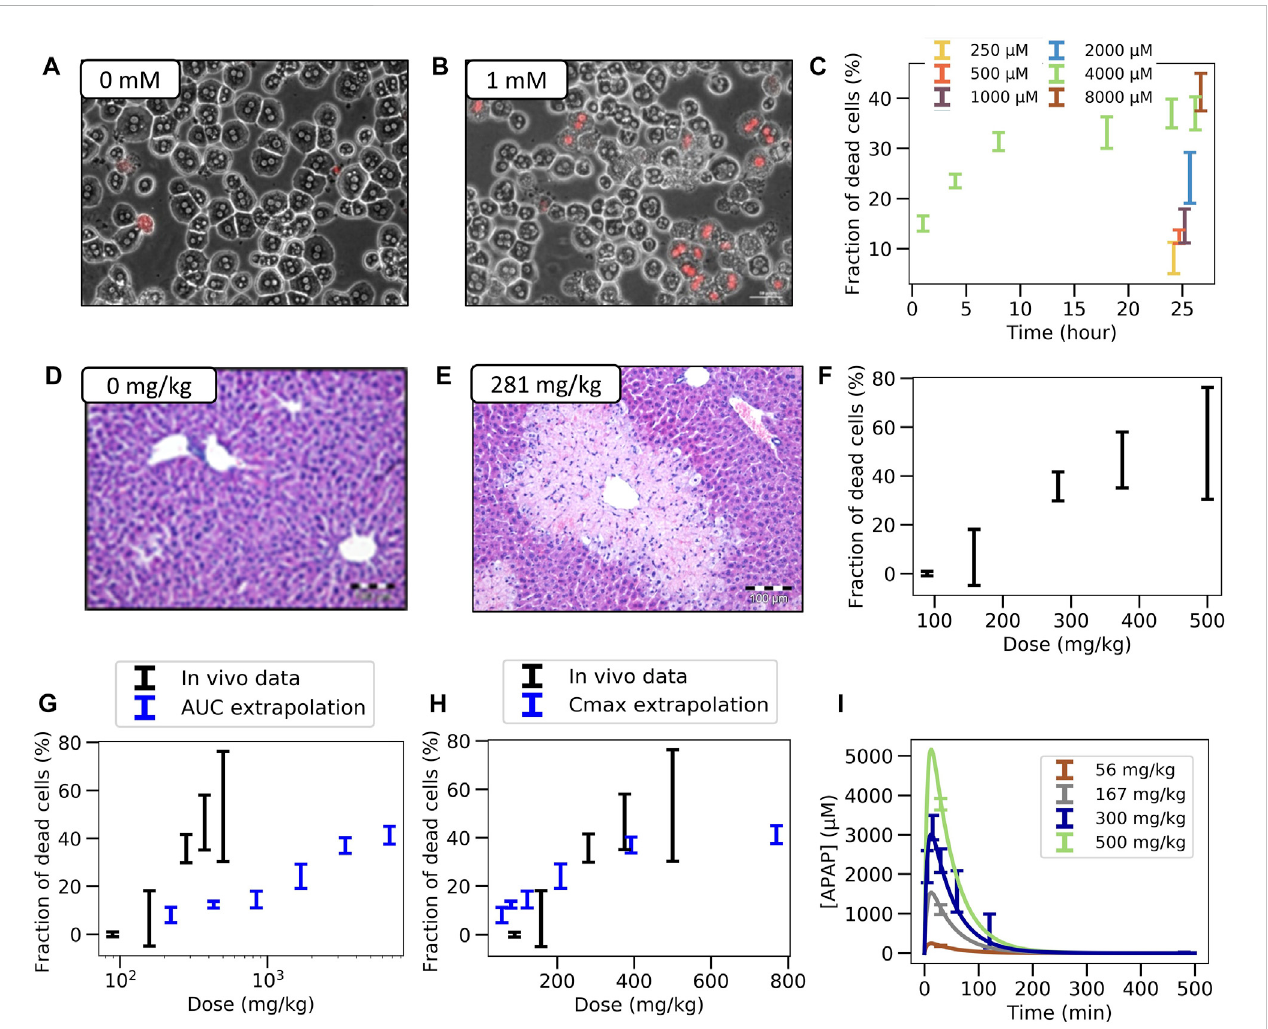
FIGURE 2 Experimental in vitro and in vivo observations. (A,B) Typical in vitro patterns of dead hepatocytes in control and after administration of 1 mM APAP. (C) Concentration-dependent hepatotoxicity in vitro . (D,E) Typical in vivo liver histology in control and after APAP-administration of 281 mg/kg body weight. (F) Dose-dependent hepatotoxicity in vivo . (G,H) Predicted (blue) and real (black) hepatotoxicity from AUC (G) and Cmax values (F) computed from the (I) Pharmacodynamics of the APAP blood concentration for various doses (symbols represent data, lines a PK- model). The PK-model permits determination of the maximal blood concentration Cmax and the area under the PK-curve for each dose. (Further results and details such as the experimental settings are in Supplementary Figures S1 –